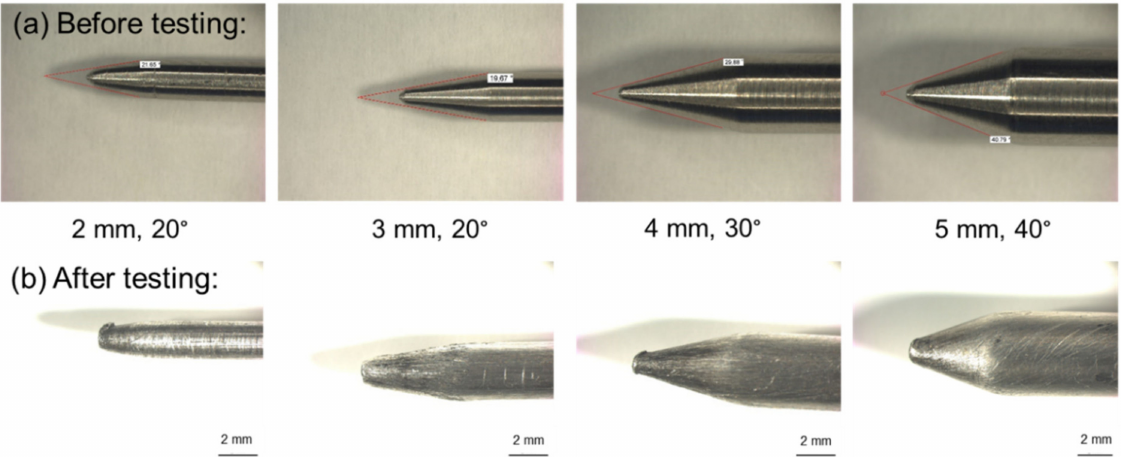
Figure 1. Representation of the nail geometries used for the nail penetration of lithium-ion batteries. ( a ) Nails with diameters of 2–5 mm and opening angles of 20–40 ◦ before the tests. ( b ) Nails after the